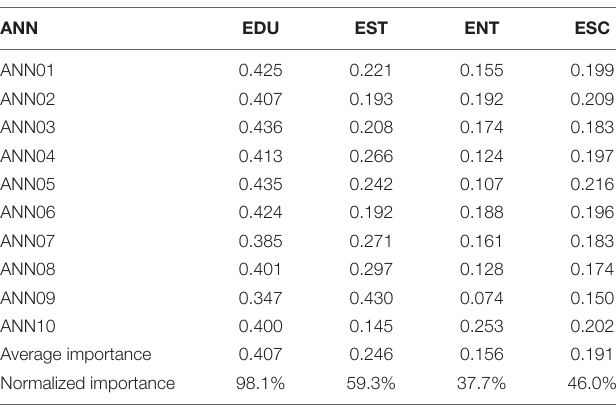
TABLE 7 | Sensitivity